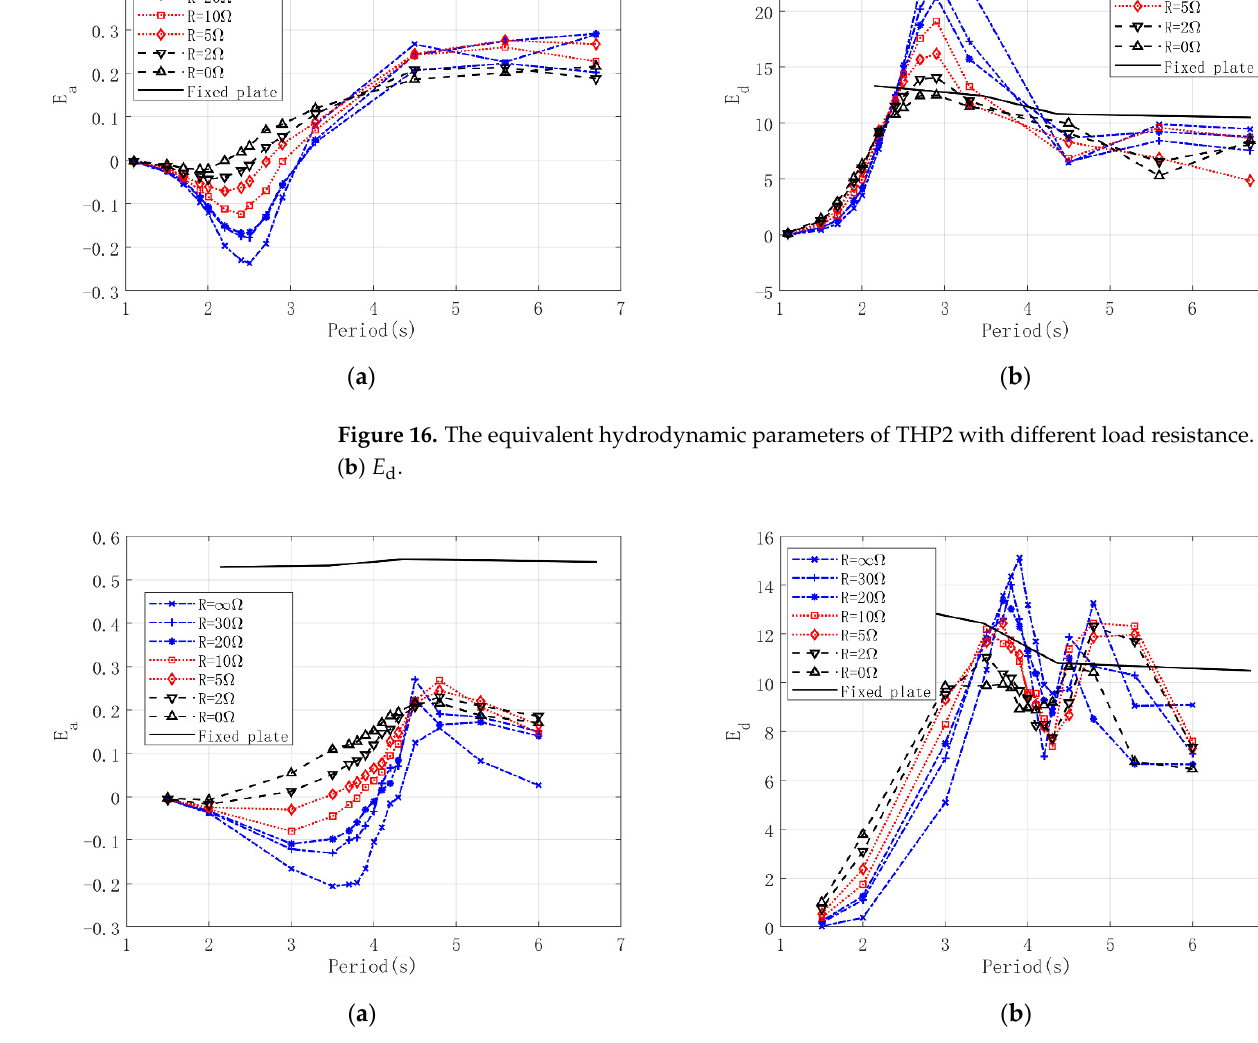
Figure 17. The equivalent hydrodynamic parameters of THP3 with different load resistance. ( a ) E a ; ( b ) E d